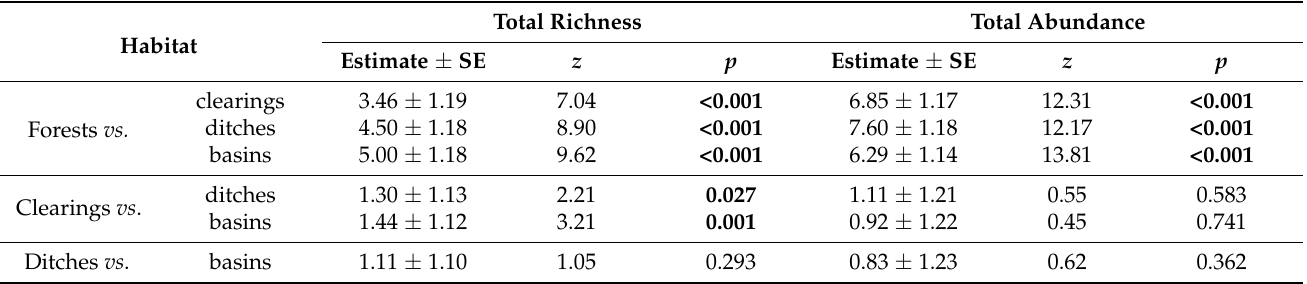
Table 3. Associations between habitat types (forests, clearings, infiltration ditches, infiltration basins) and bee species richness and abundance, based on generalized linear mixed models (GLMMs).